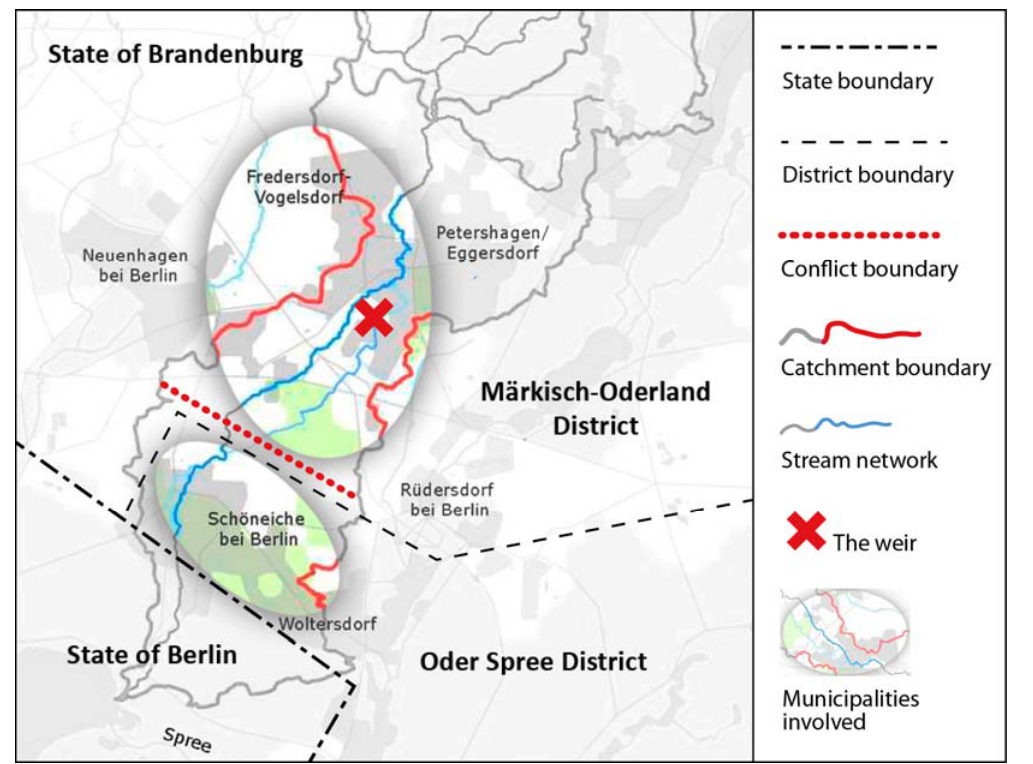
Figure 3. The conflict area and boundaries in the lower